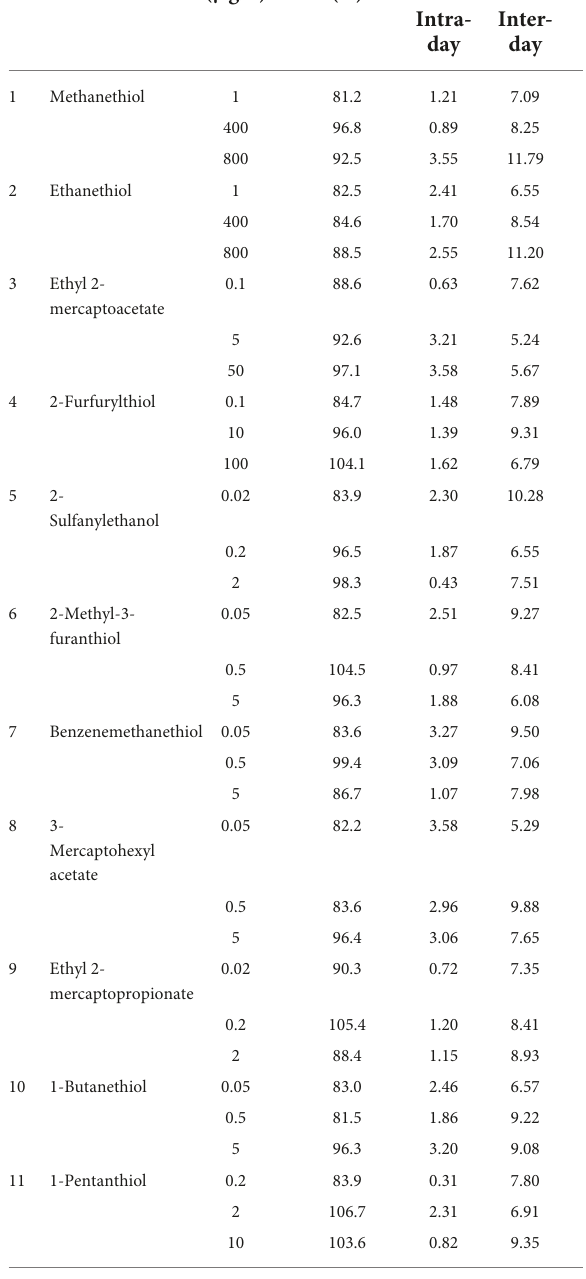
TABLE 5 Recovery and precision of the established method for derivatized thiols.